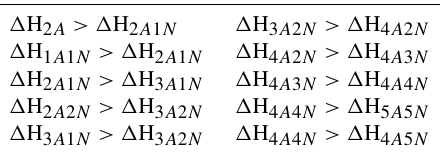
Table 3. Additional restrictions on the cluster formation enthalpies arising from the requirement that each individual molecule is bound The cluster formation enthalpy of the i th cluster is denoted by (cid:49) H i . The notation xAyN corresponds to a cluster with x sulfuric acid and y ammonia